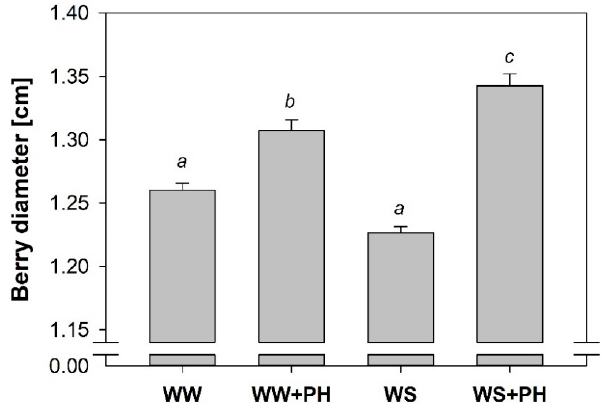
Figure 7. Effects of water stress (WS) compared with well-watered conditions (WW) and PH application, on berry diameter at harvest. Values are means ± SE of 50 berries in three replicates per treatment. Different letters indicate significant differences according to Tukey’s test ( p < 0.05). Table 1. Effects of water stress (WS) and PH application on cluster numbers, cluster weight, and grape composition at harvest compared with well-watered conditions (WW). Values are means ± SE of 50 berries in three replicates per treatment. ns = no significant differences according to Tukey’s test ( p ≤ 0.05).